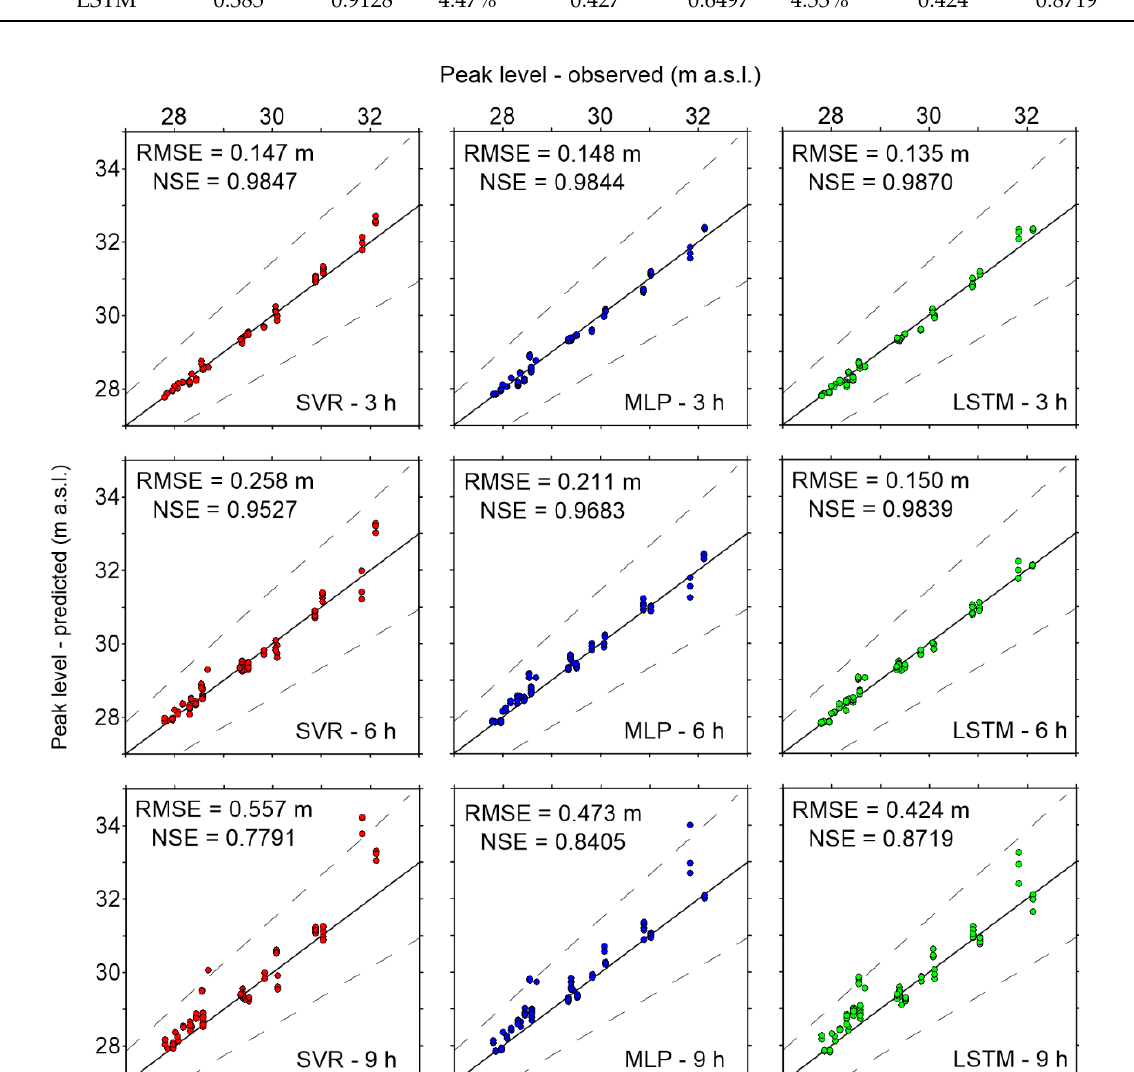
Figure 7. Comparison of observed and forecasted peak levels in Colorno (testing dataset) for time lags of 3, 6, and 9 h. Dashed lines indicate a ±20% error (relative to the peak level above the river bed, i.e., peak water depth).